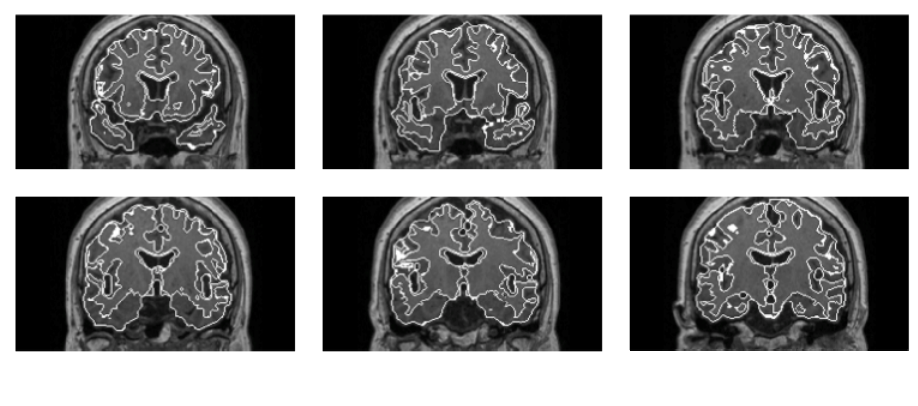
Figure 13. Segmentations of brain regions (outer white line) and white matter regions (inner white line) obtained by the proposed method from a non-AD patient in multiple coronal planes